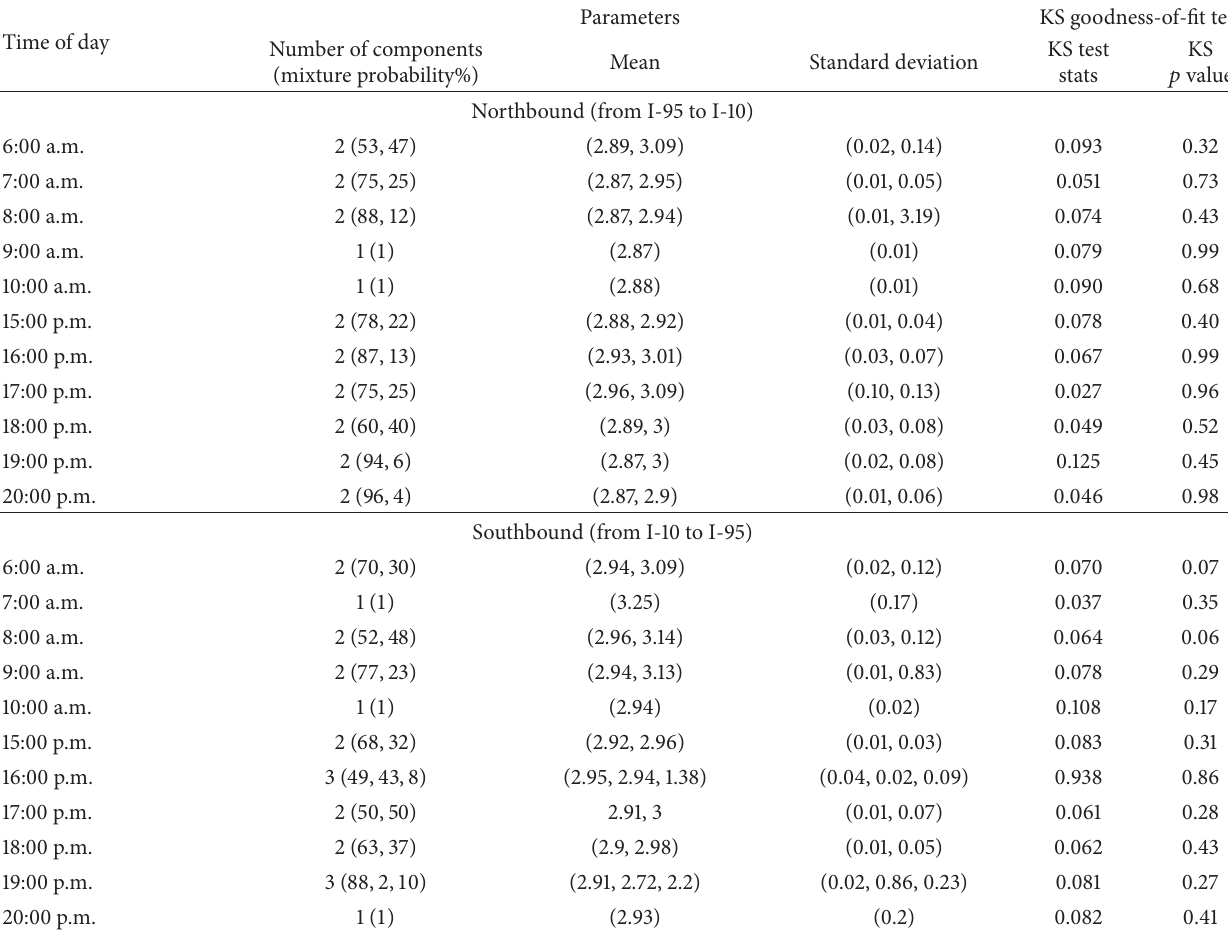
Table 2: Corridor parameters and KS goodness-of-fit.